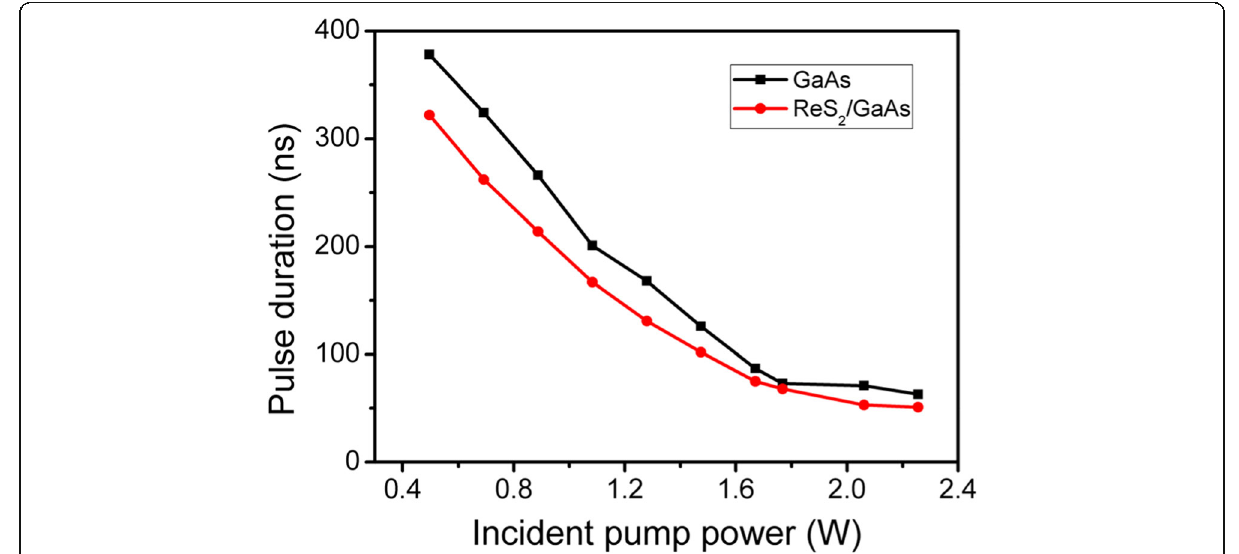
Fig. 4 Pulse duration of the Q-switched laser versus the incident pump